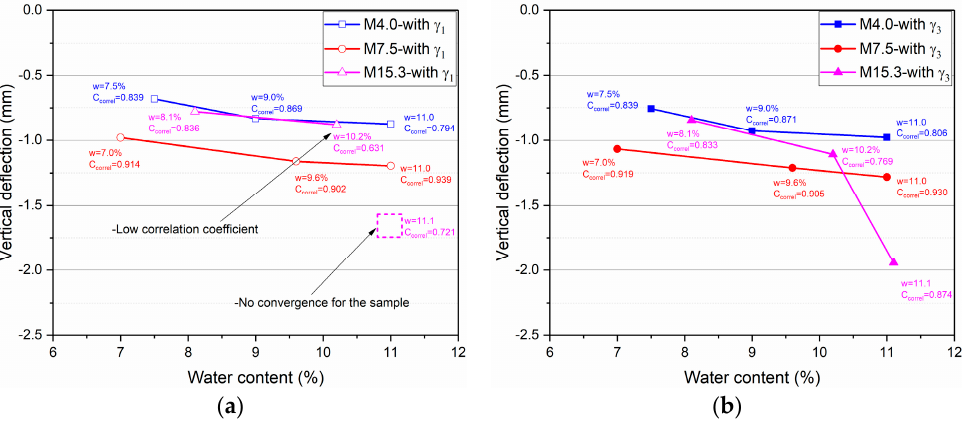
Figure 11. Calculation of the vertical deflection, ( a ) with γ 1 ; ( b ) with γ 3 .